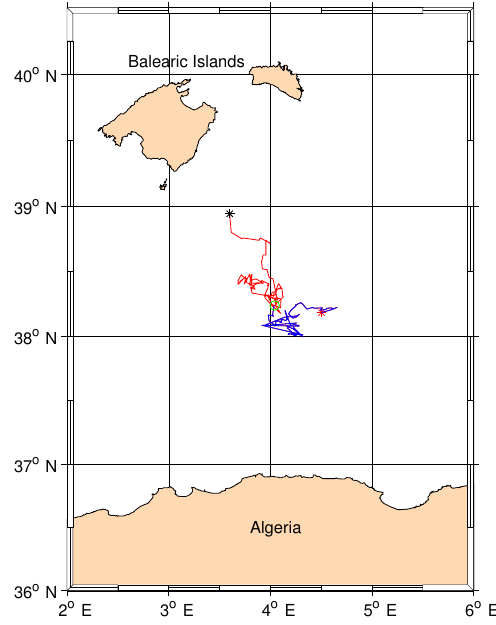
Figure 3. Tracks of the eddy described by Cotroneo et al. (2016) before and after the application of the eddy continuity routine. The blue line shows the track without running the continuity routine (the red star indicates the formation point), while the red line (star) indi- cates the new part of the trajectory (termination). The green circle shows the junction of the two tracks.